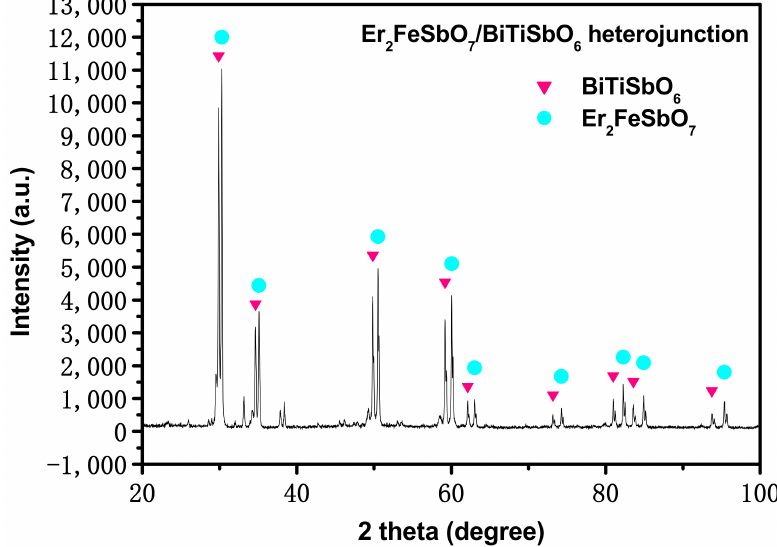
Figure 2. The X-ray diffraction spectrum of Er 2 FeSbO 7 /BiTiSbO 6 HJ before reaction.